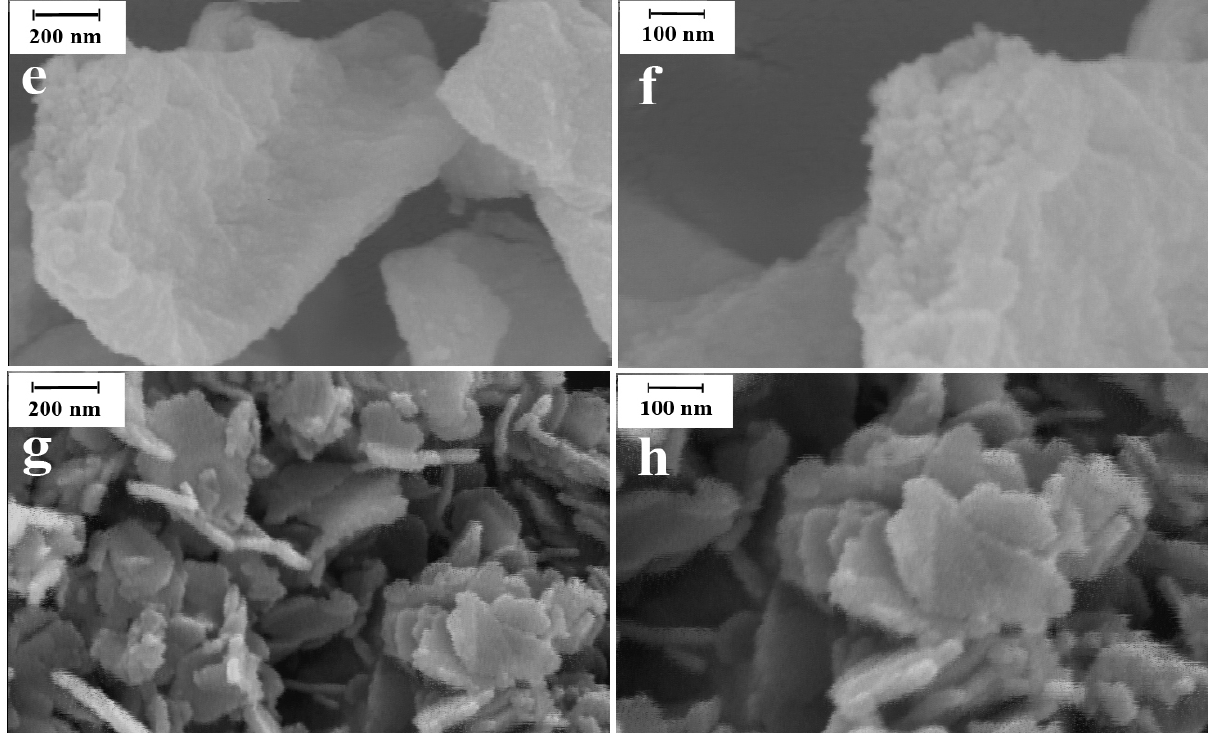
Fig. 7. FE-SEM images of (e and f) Gd